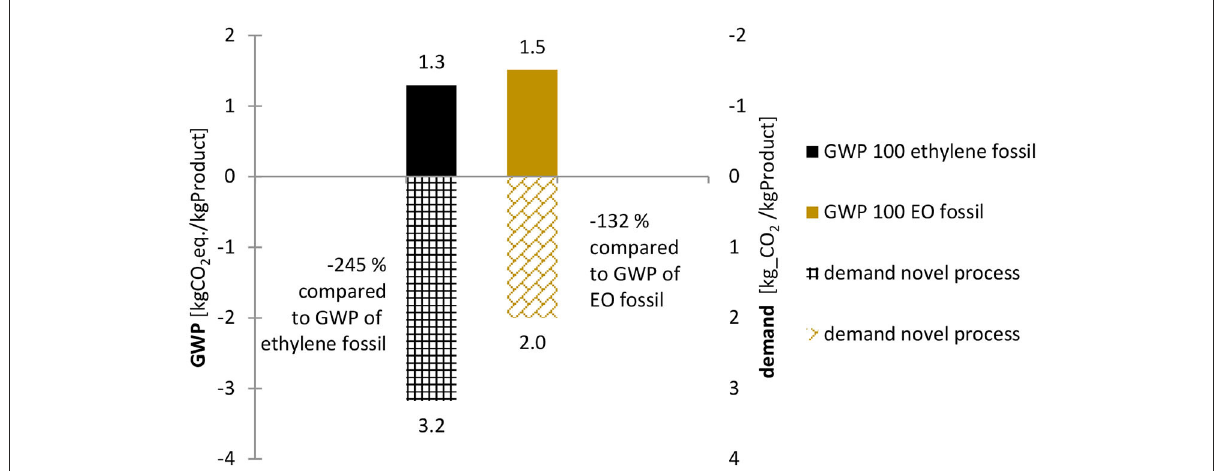
FIGURE3 Fossil benchmark’s GWP and stoichiometric CO 2 -demand per 1kg of product of novel process: Comparison of the average GWP 100 [kg CO 2 eq.] of 1kg ethylene (GaBi sphera, 2020c) and EO (GaBi sphera, 2020g) produced compared to the stoichiometric CO 2 demand of the same products generated with the novel process. Sources: Own illustration based on LCA data by GaBi sphera.